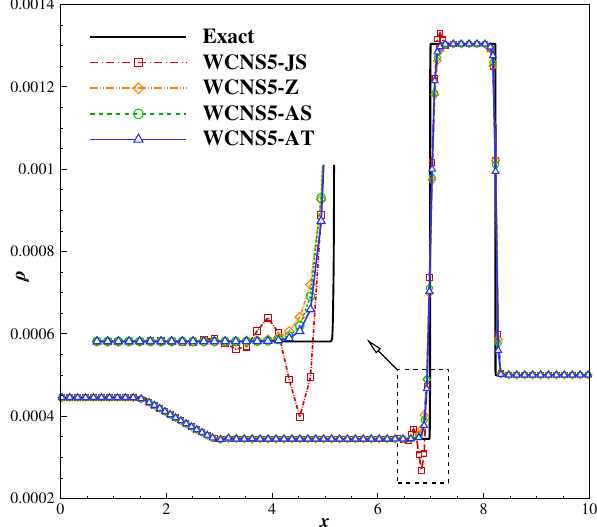
Figure 13. Density distribution of Lax shock tube problem with λ = 10 − 3 . The computation is advanced to t = 1.8, with 201 grid points and CFL = 0.1. Figure 14 presents density distribution results. The reference solution is given by the WCNS5-JS scheme using 6401 grid points. Compared with other WCNS5 schemes, the WCNS5-AT scheme yields higher resolution for both shocks and smooth waves, especially for the high-frequency waves behind the main